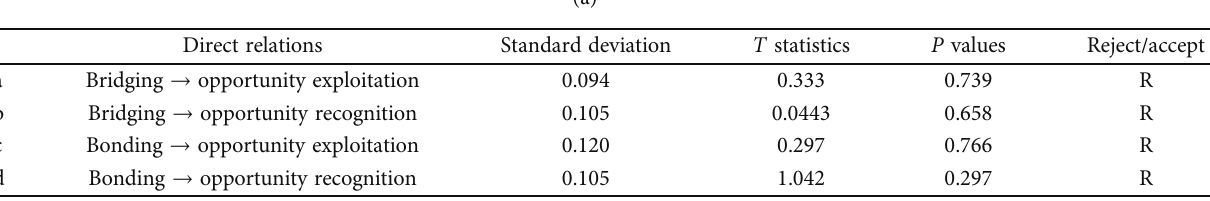
Table 5: Direct and indirect relationships between online SC dimensions and